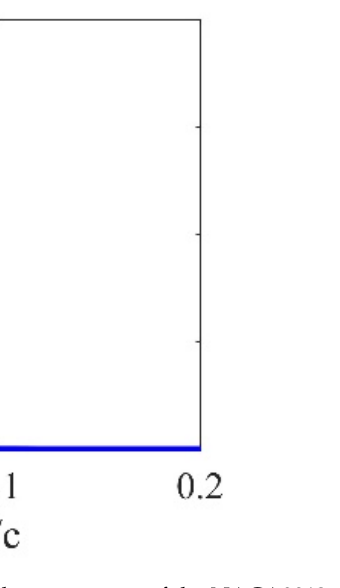
Figure 4. Collection efficiency of the upper part of the NACA0012 airfoil as used on the flat plate surface [40].